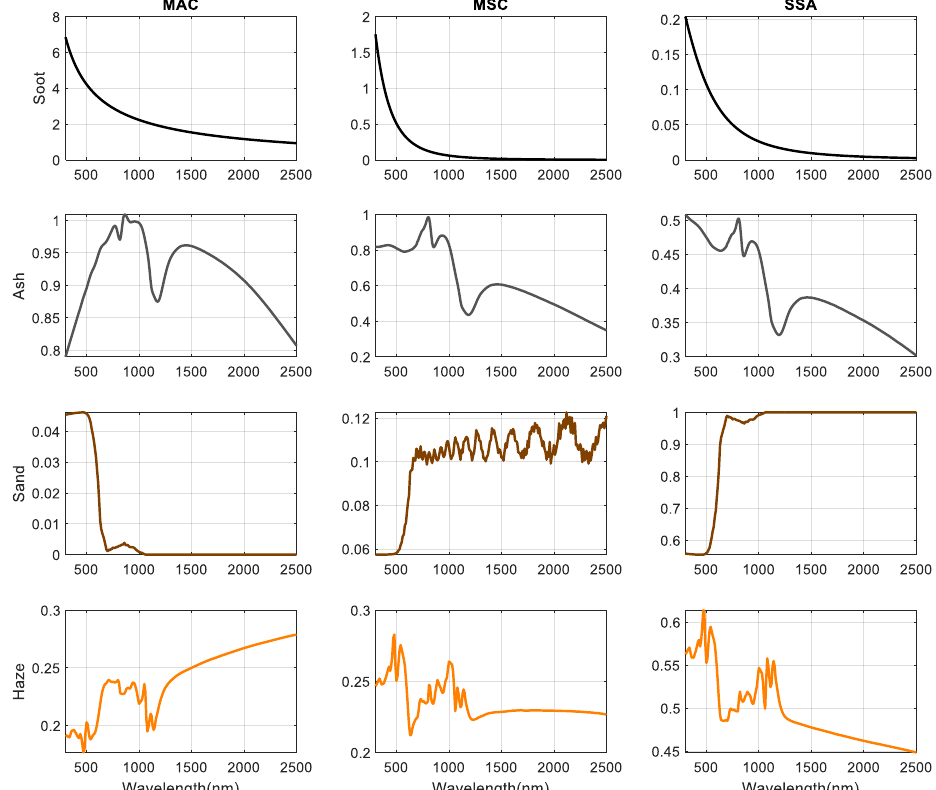
Figure 9. Modelled results of MAC (Mass Absorption Cross Section), MSC (Mass Scattering Cross Section), and SSA (Single Scattering Albedo) with the conditions and morphology of soot, ash, sand, and haze.